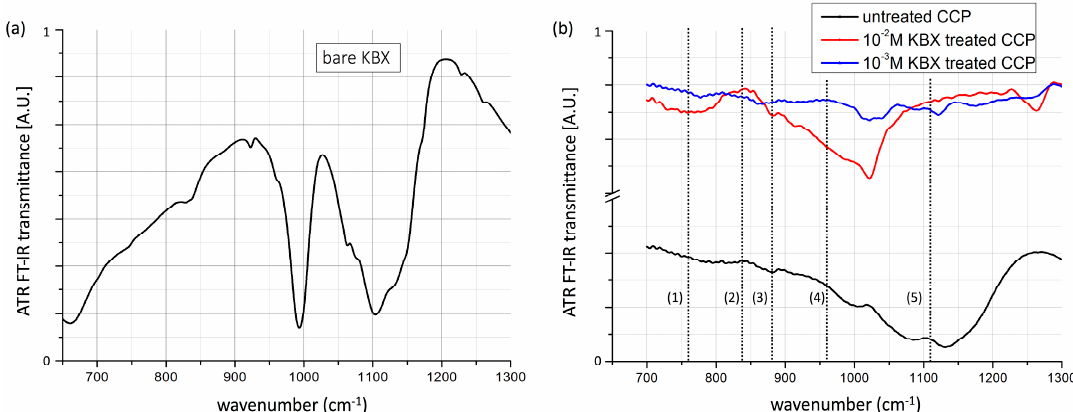
Figure 1. Macroscopic ATR FT-IR spectra of ( a ) pure KBX and ( b ) untreated CCP substrate, as well as CCPX-2a and CCPX-3a samples. The dashed lines 1 to 5 in ( b ) correspond to the spectral positions of